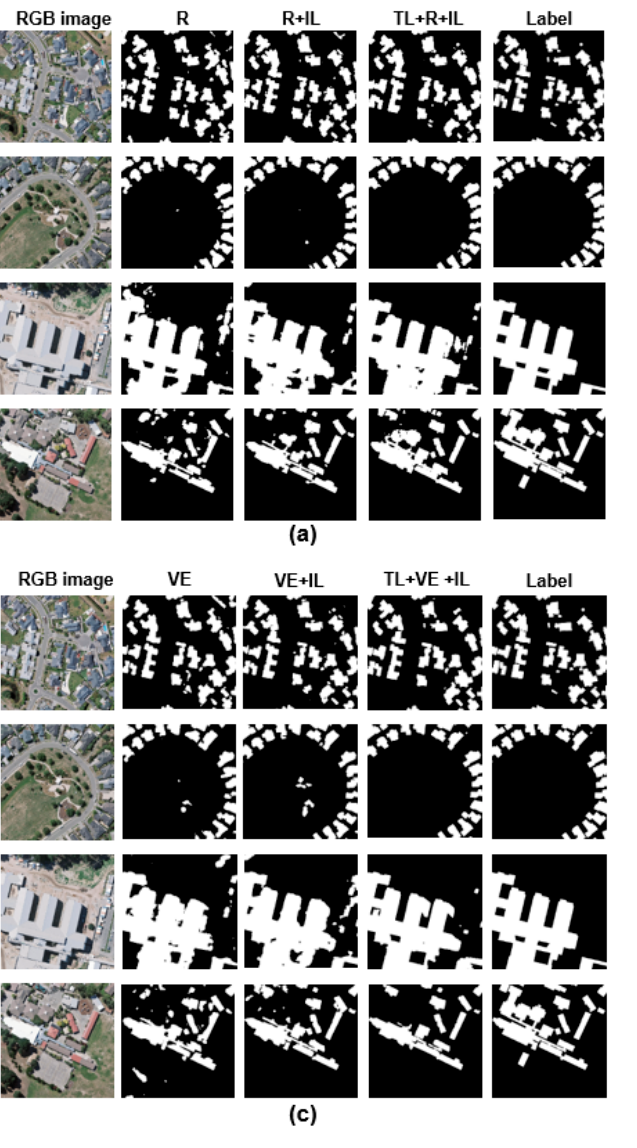
Figure 7. Illustration of the results of building extraction in the 4th iteration based on three proposed frameworks on the WHU aerial building dataset. The first column indicates the aerial image. Columns 2, 3, and 4 indicate the segmentation results of DeeplabV3+ with AL; DeeplabV3+ with AL and IL; and DeeplabV3+ with TL, AL, and IL, respectively. The last column shows the ground truth of each aerial image. Subfigures ( a – d ) represent the results for random selection, entropy, vote entropy, and margin sampling, respectively.